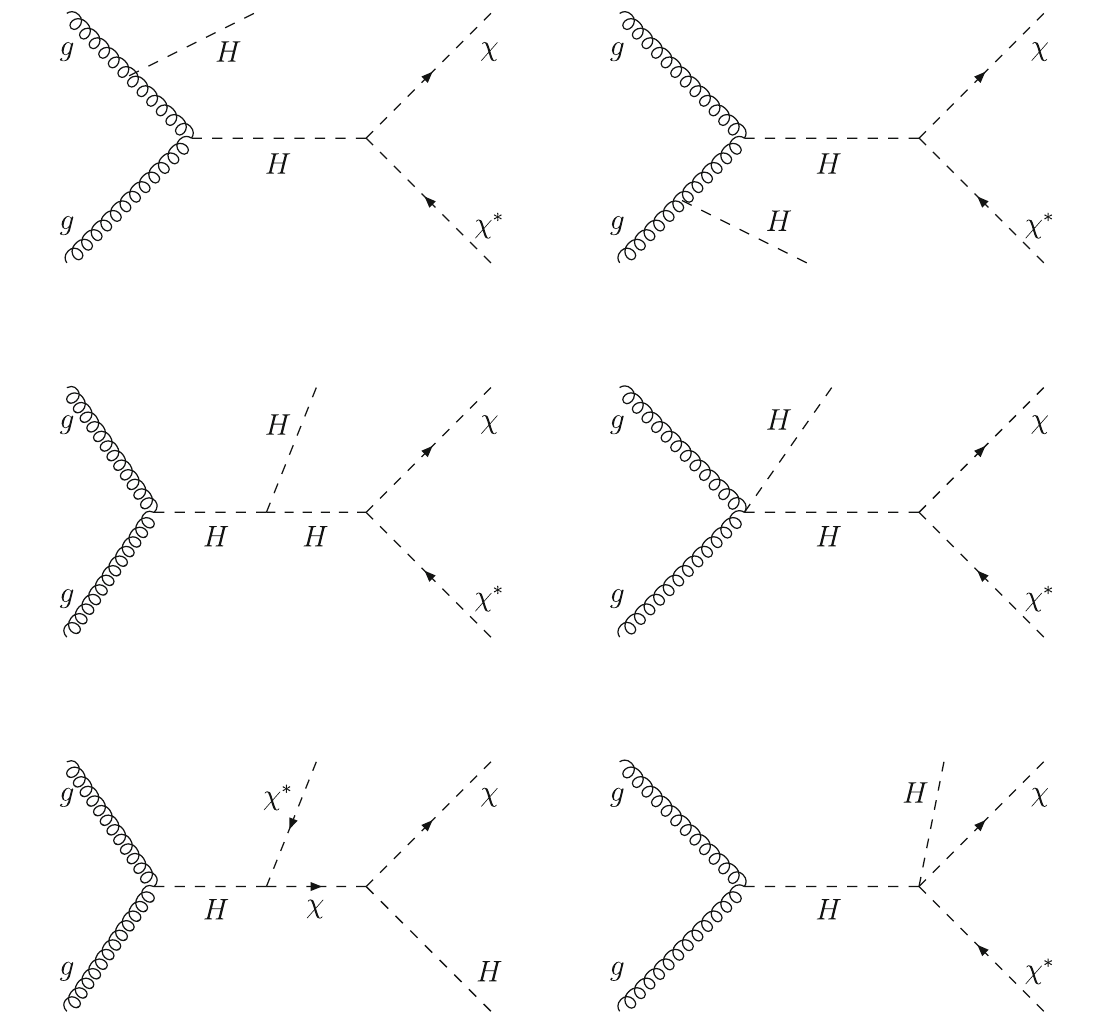
Fig. 5 Mono- H production at the LHC associated with the emission of a dark matter